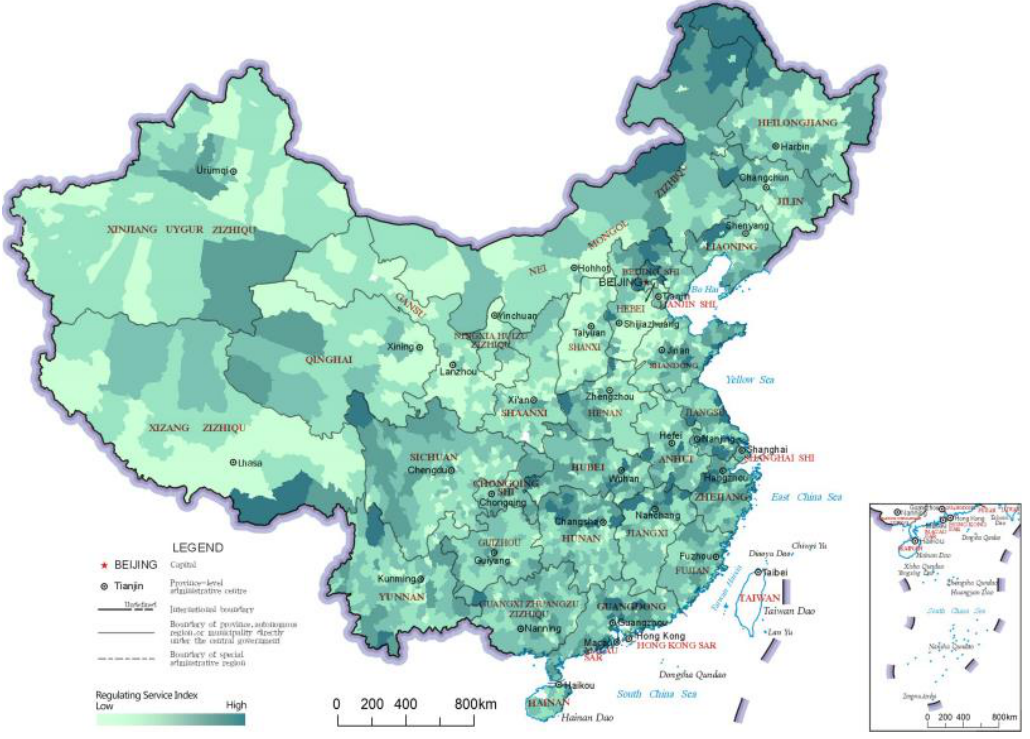
Figure 9. Distribution map of composite GEP indices of the county-level regions in China.